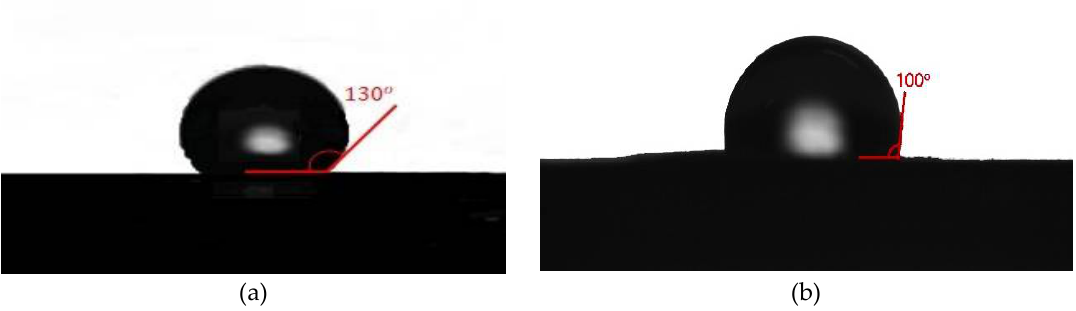
Figure 5. Contact angle: ( a ) water droplet on PVDF membrane surface [36]; ( b ) methylene blue droplet on PVDF membrane surface.